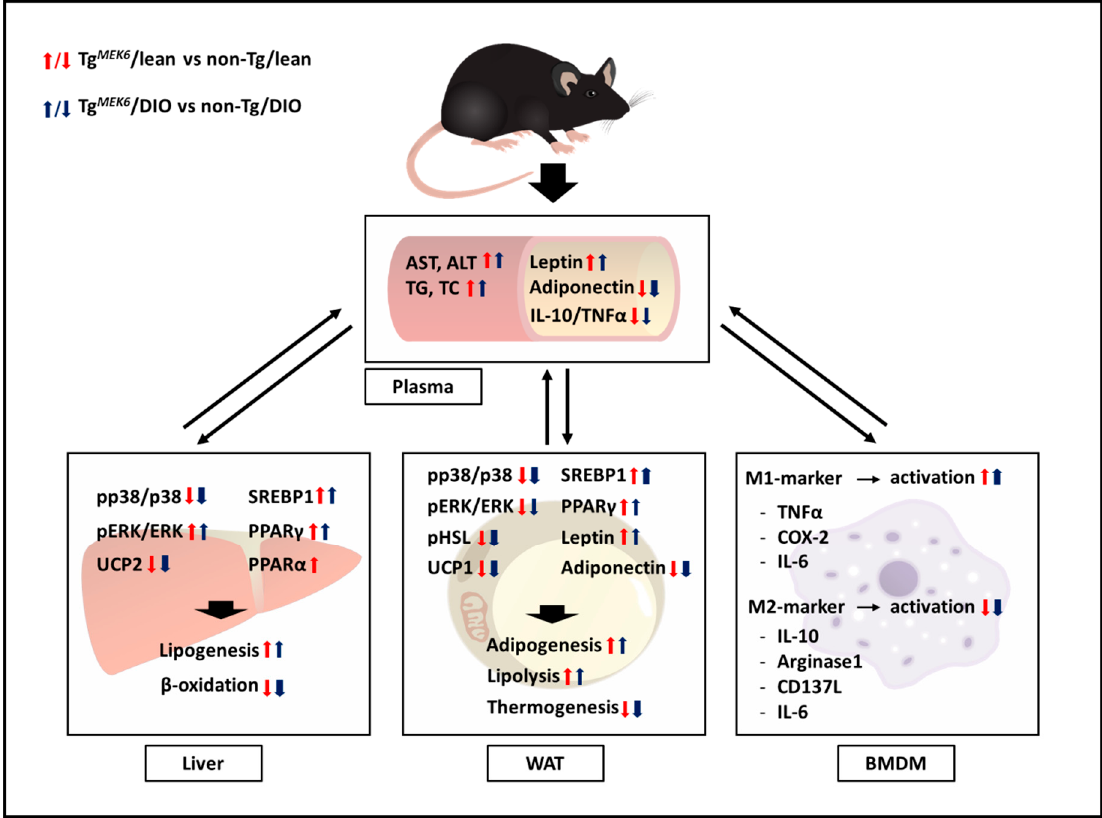
Figure 8. Regulation of lipid accumulation and Inflammation in Tg MEK6 /lean and Tg MEK6 /DIO. Red allows show the effect of Tg MEK6 /lean compared to non ‐ Tg/lean, and blue allows show an effect of Tg MEK6 /DIO compared to non ‐ Tg/DIO. Thick allows indicate cases with large differences. Case where there was no change was not expressed.